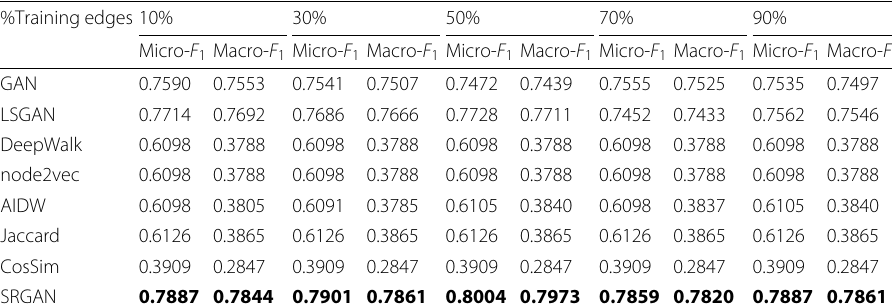
Table 4 Micro- F 1 and Macro- F 1 scores on HepTh dataset in link prediction ( α = 0.9, β =